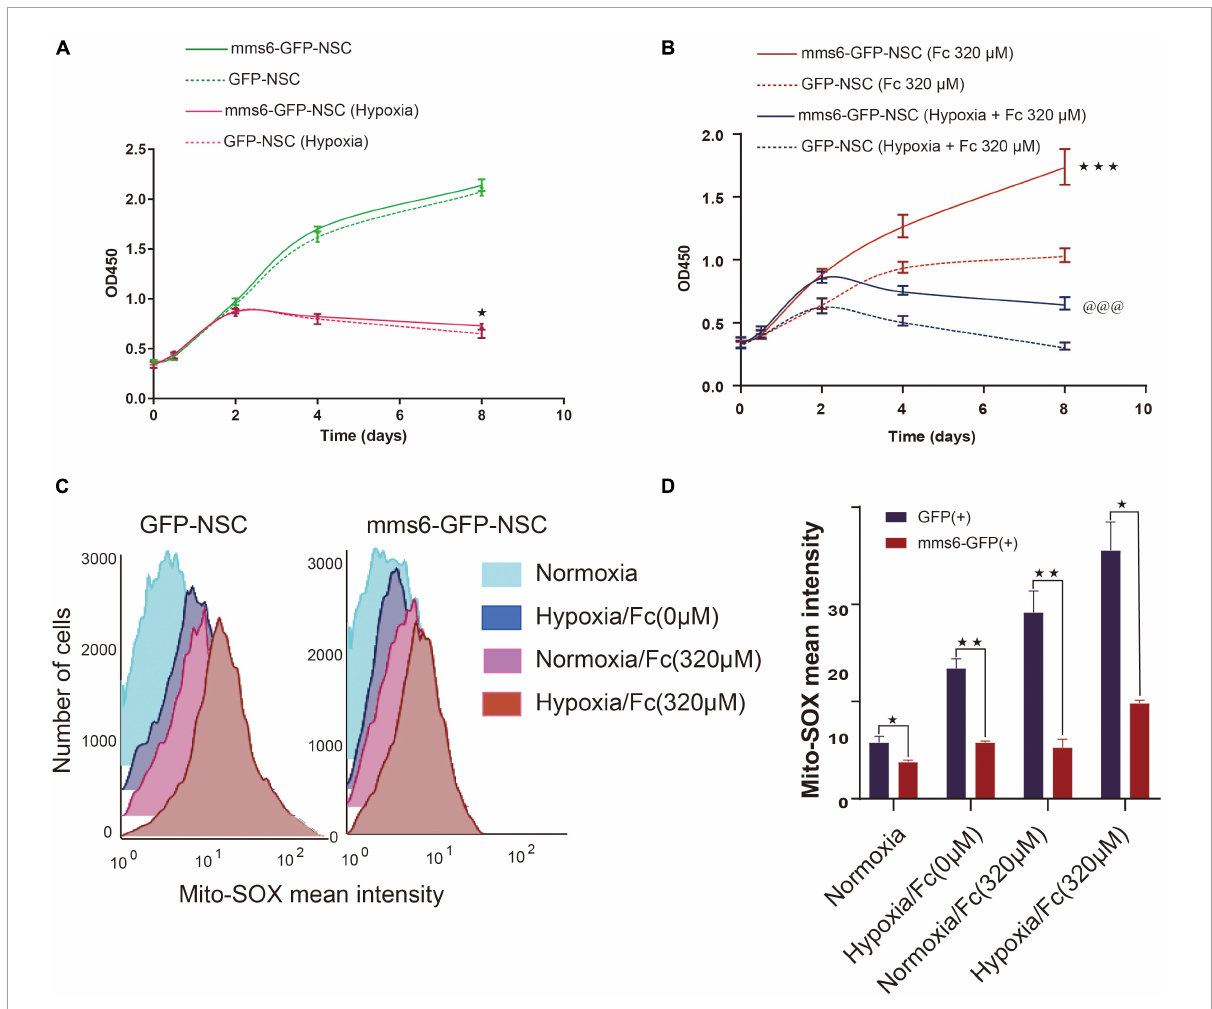
FIGURE1 The expression of mms6 can lead to the resistance of the harm caused by iron overloading on the growth of neural stem cells and decrease the production of superoxide anions. (A) Growth curve on consecutive days under normoxic/no iron and hypoxic/no iron conditions. (*) indicates that under hypoxic/no iron conditions, the OD450 value on the eighth day of mms6 -GFP-NSCs was significantly higher than that of the control group ( P < 0.05). (B) Growth curve on consecutive days under high levels of iron (320 µ M) or hypoxia/high levels of iron (320 µ M). *** or indicates a P -value of the significant difference of the 8-day growth curve between GFP-NSCs and mms6 -GFP-NSCs, < 0.001. (C) Histograms of superoxide anion staining of mms6 -GFP-NSCs and GFP-NSCs cultured under different conditions. (D) Statistical graphs of the superoxide anion staining fluorescence intensity of mms6 -GFP-positive NSCs and GFP-positive NSCs cultured under different conditions. * indicates a P -value < 0.05; ** < 0.01; and *** <